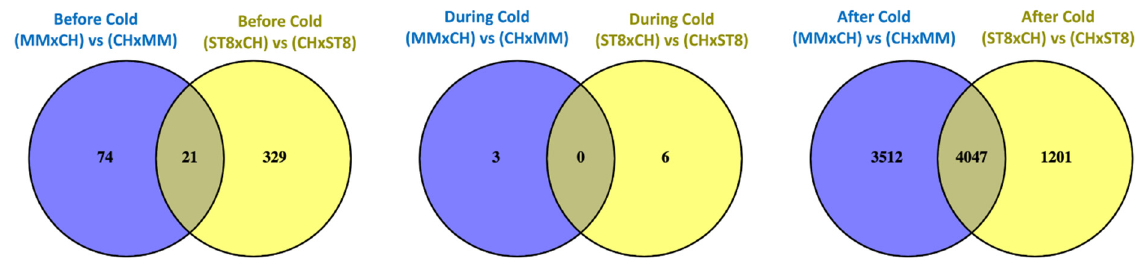
Figure 5. Venn diagrams comparing significantly ( FDR < 0.05) differentially expressed genes (DEGs) across reciprocal hybrids sets, MMxCH versus (vs) CHxMM (blue) and ST8xCH vs CHxST8 (yellow), within each timepoint before cold treatment (Before Cold), at hour 3 during cold treatment (During Cold), and 24 h after onset of cold treatment (After Cold). Plants were grown in a greenhouse at 28 °C for 10 days then plants were treated at 4 °C for 5.5 h at a light intensity of 270 µmol·s − 1 ·m − 2 .